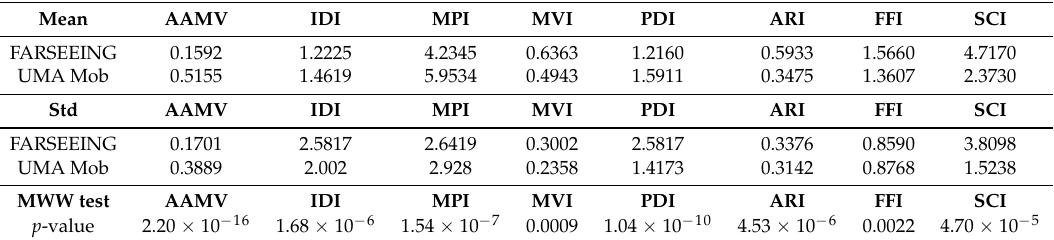
Table 3. Comparison between FARSEEING (sensor on the lower back) and UMA Fall (sensor on the waist) datasets: the mean and standard deviation (Std) of the features computed for all the TS that correspond to a fall. The last row shows the p -values from the Mann-Whitney-Wilcoxon test (MWW test), showing that the features from FARSEEING and UMA Fall do not follow the same probability